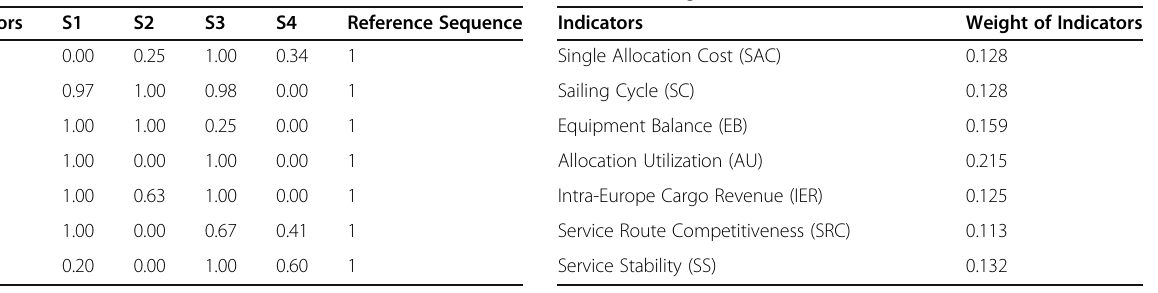
Table 13 Normalized Data and the Optimal Reference Sequence (Source: authors)